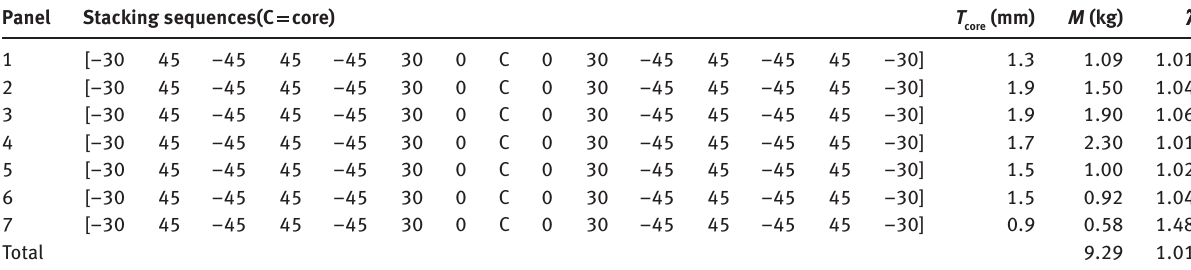
is the core thickness). core